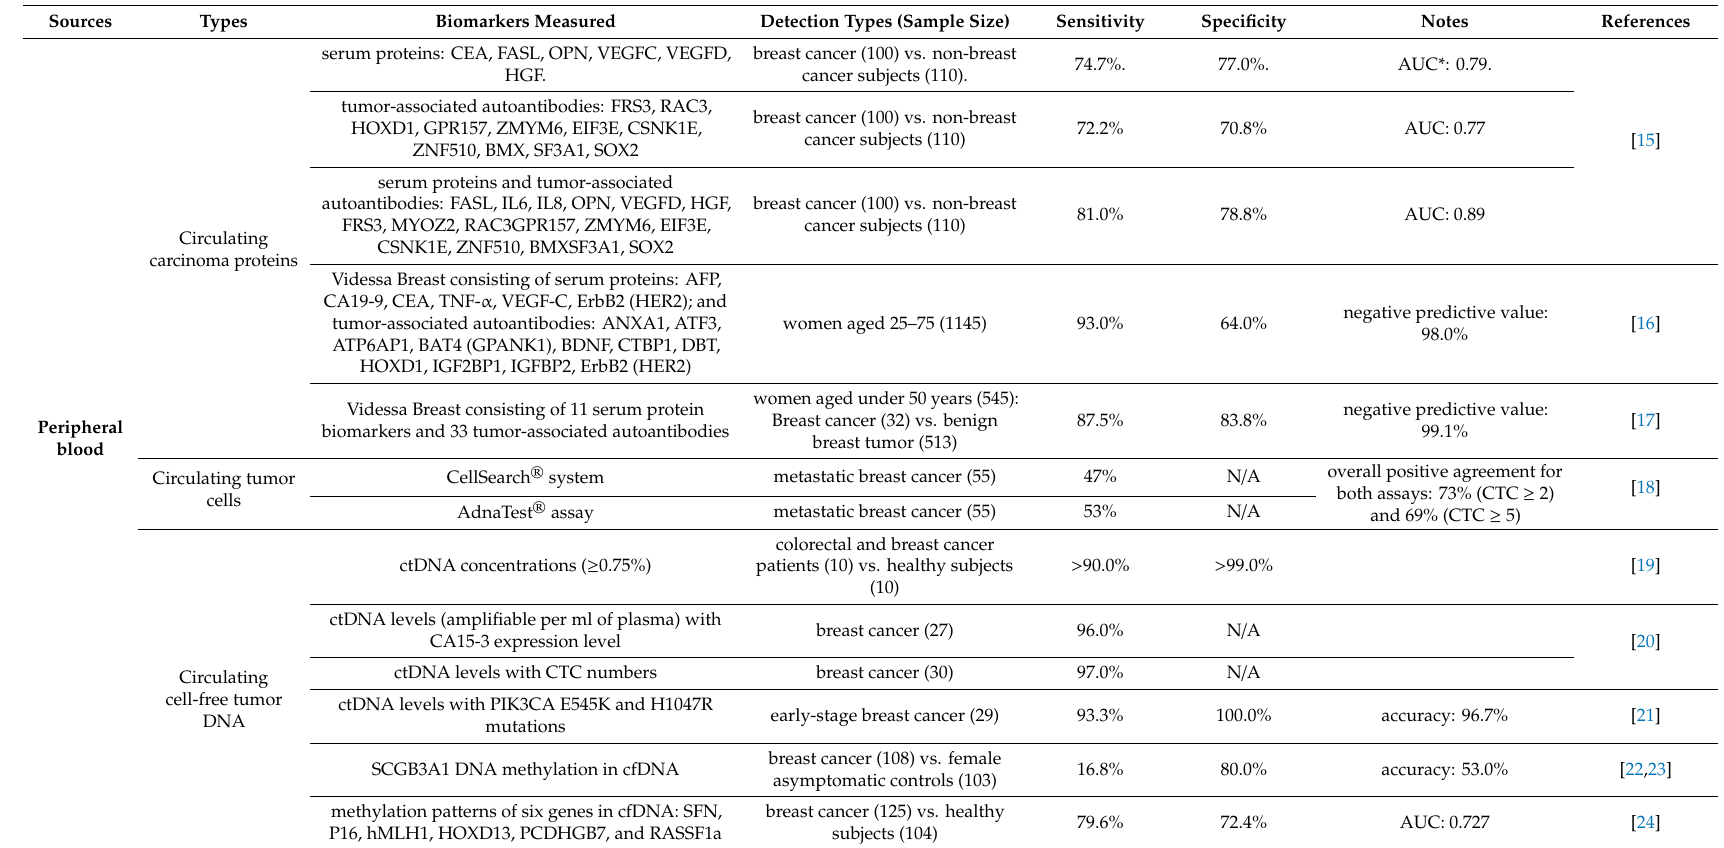
Table 1. Summary of potential non-invasive biomarkers for early detection of breast